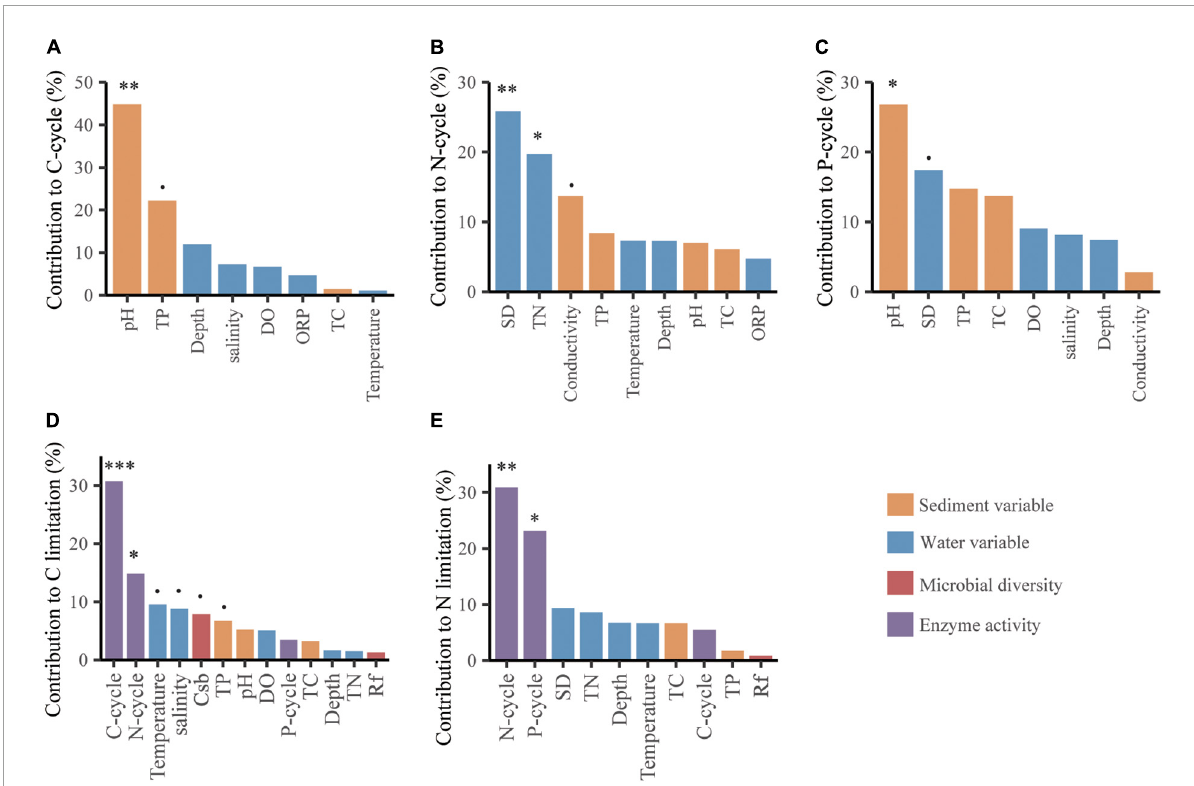
FIGURE4 The contributions of abiotic factors on C-/N-/P-cycle (A–C) , and of abiotic and biotic factors on microbial C (D) and N (E) limitations based on random forest analyses. The columns filled with yellow, blue, red and violet indicate sediment variable, water variable, microbial diversity and enzyme activity, respectively. The microbial diversity includes the richness of bacteria (Rb) and fungi (Rf), and the community structure of bacteria (CSb) and fungi (CSf) represented by the first axis of detrended correspondence analysis of the communities. The significance of each variable was shown above the column. p < 0.1, *p < 0.05, **p < 0.01, ***p <